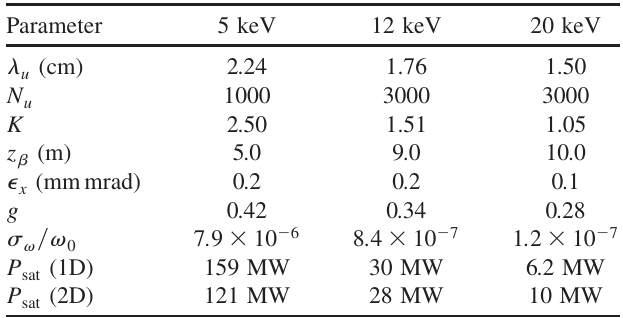
TABLE I. Possible undulator and beam parameters for three different radiation wavelengths produced by a 7-GeV beam with I peak ¼ 10 A and (cid:1) (cid:3)=(cid:3) 0 ¼ 0 : 02% . The saturated power P sat given by our 1D code and the 2D code GINGER were determined assuming mirror losses (cid:1) ¼ 15%